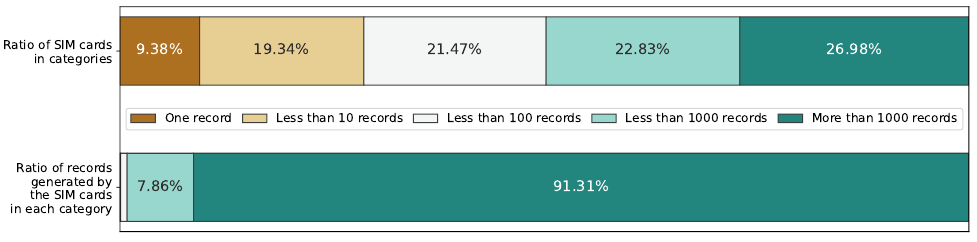
Figure 1. Subscriber Identity Module (SIM) cards categorized by the number of activity records. The SIM cards with more than 1000 activity records (26.98% of the SIM cards) provide the majority (91.31%) of the